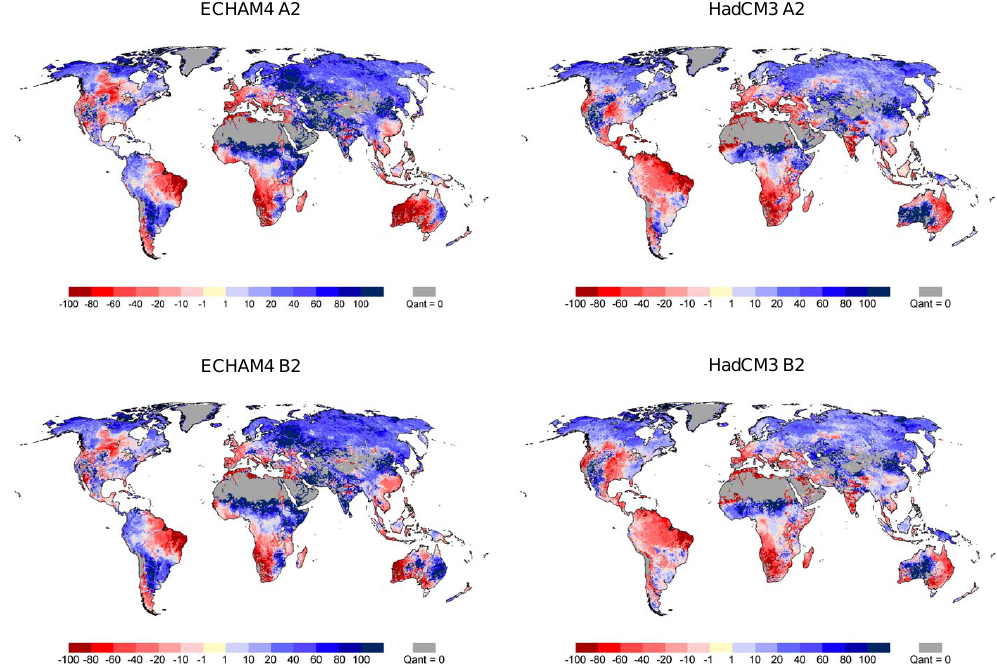
Fig. 1. Impact of climate change on river discharge: change of monthly low flows Q 90 , I LF , between 1961–1990 and 2041–2070. Emissions scenarios A2 and B2 as implemented by the global climate models ECHAM4 and HadCM3, river flows anthropogenically altered due to water withdrawals and reservoirs of the year 2002 (CC-ANT – ANT, in % of